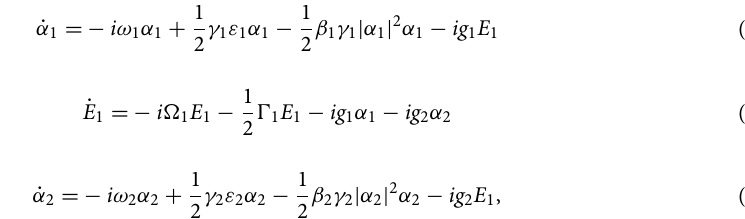
Figure 1. ( a ) Laser oscillation is interpreted as limit cycle oscillation in the nonrotating frame, where the laser frequency ω corresponds to the frequency of the limit cycle. With the amplitude | α | = of the laser, we define the limit cycle orbit as ( x (φ) , y ((φ))) = real Re [ α ] and imaginary parts Im [ α ] of the field, respectively. ( b ) Illustration of two PhC lasers (L1 and L2) indirectly coupled via a cold cavity (C1). The three cavities are evanescently coupled with coupling strengths g 1 and g 2